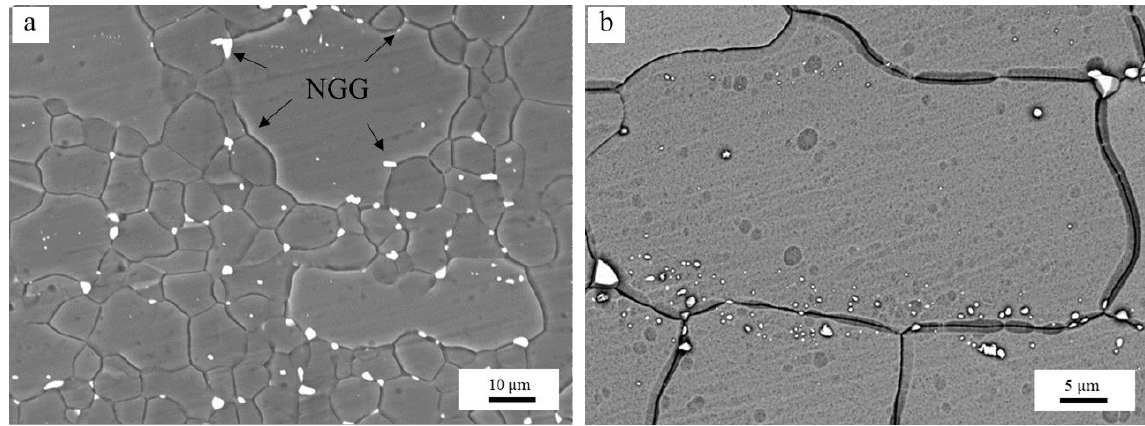
Figure 3. SEM images of AZ61 annealed at 300 °C for 48 h. ( a ) The distribution of second phase particles, ( b ) The second phase particles in abnormal grain.